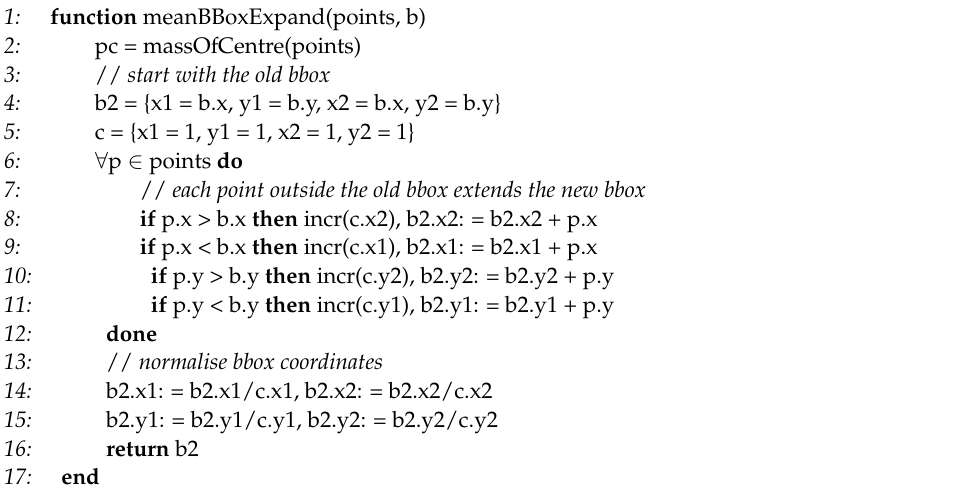
Algorithm 2 . Mean bounding box expansion applied to a two-dimensional point cloud and mean bound